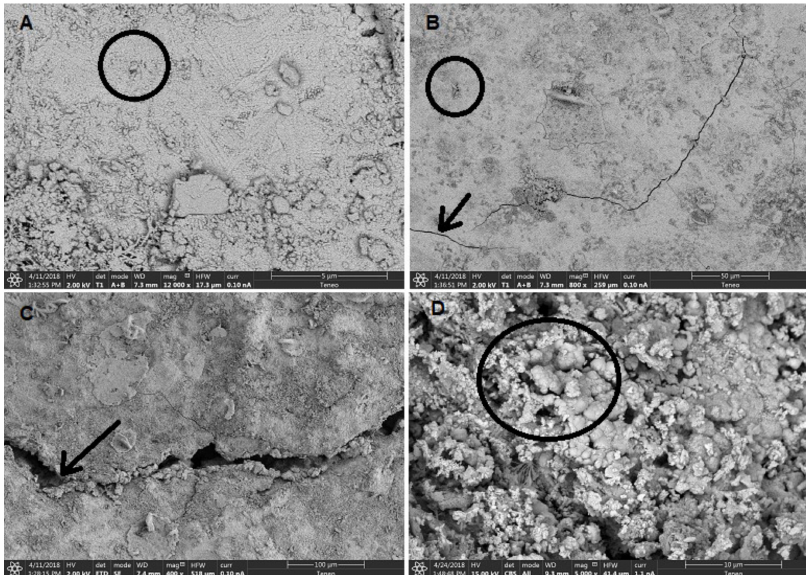
Figure 9. SEM images of group II mortar samples. ( A ) Compact internal structure with occluded pores; ( B ) Compact internal structure with occluded pores and fissures; ( C ) Small cracks detail; ( D ) Microcrystalline aggregates of calcite.